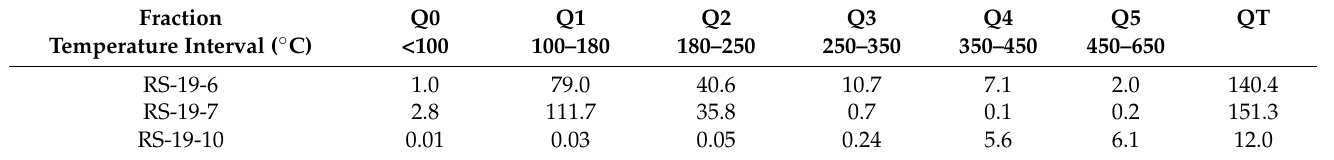
Table 5. Results of Rock-Eval pyrolysis (‘Multi Heating Rates’